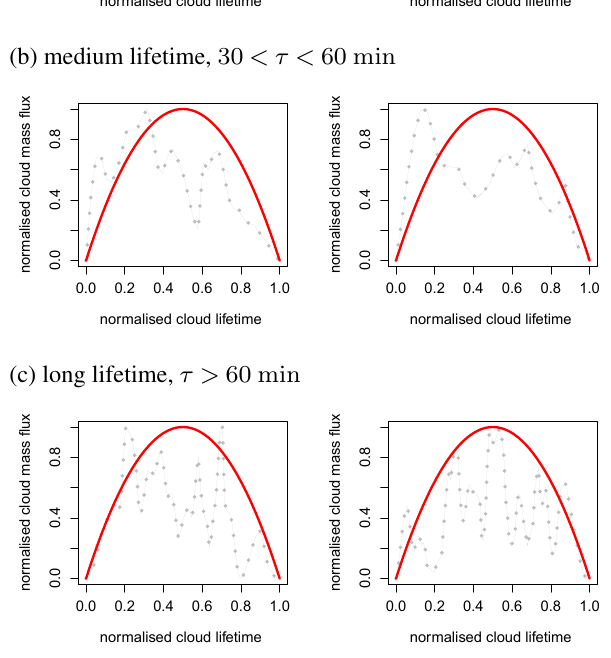
Figure 8. Idealised function for the cloud lifecycle (red) and the examples of individual cloud lifecycles (gray dots) from the LES RICO-140 case, after the cloud